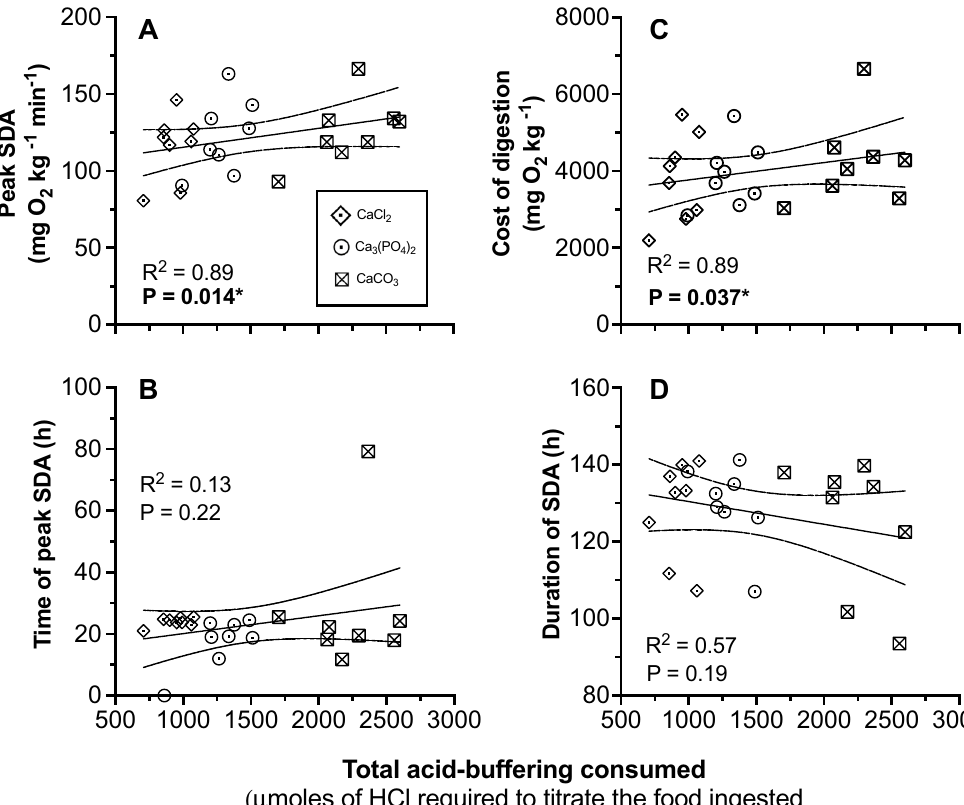
Figure 6. Change in the peak SDA (MO 2 ) ( A ) time of peak ( B ), total energetic cost of digestion (SDA; C ) and total duration of the SDA ( D ) in juvenile rainbow trout ( Oncorhynchus mykiss ) fed voluntarily on a 2.5% ration of one of three experimental feeds (n = 8) of varying buffer capacity. The ranked order (and relative magnitude) of the dietary acid-buffering capacity of each diet was CaCO 3 > Ca 3 (PO 4 ) 2 > CaCl 2 (2.4 > 1.4 > 1). Solid line represents the regression line while the dotted line represents the 95% confidence interval (CI). Significance was accepted at P < 0.05 following a linear mixed effects model. Each data point represents values from individuals.